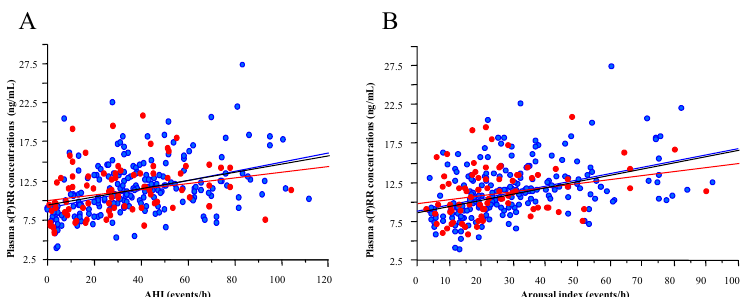
Int. J. Mol. Sci. 2017 , 18 , 1313 4 of 9 The presence of hypertension had no significant effects on plasma s(P)RR concentrations in both Figure 2. Significant correlations between plasma s(P)RR levels and apnea-hypopnea index (AHI) ( A ); male and female OSAS patients (Figure 3A,B). Moreover, the types of anti-hypertensive drugs had no significant effects on plasma s(P)RR concentrations in OSAS patients. On the other hand, the and between plasma s(P)RR levels and arousal index ( B ) in 289 subjects (206 men and 83 women). The presence of type 2 diabetes mellitus (T2DM) or chronic kidney disease (CKD) affected plasma s(P)RR subjects comprised of 259 patients with obstructive sleep apnea syndrome (OSAS) and 30 non-OSAS concentrations in OSAS patients in both sexes (Figure 3A,B). Female OSAS patients with both T2DM control subjects. The dark lines; trend for all subjects. The blue lines and blue circles; male subjects. The and CKD (diabetic kidney disease) showed higher levels of plasma s(P)RR than the other three groups (Figure 3D), whereas male OSAS patients with both T2DM and CKD did not (Figure 3C). red lines and red circles; female subjects. Reproduced from the Reference [23] with kind permission These findings suggested that the presence of diabetic kidney disease had a greater effect on plasma from the Tohoku University Medical Press, Sendai, Japan. s(P)RR concentrations in female OSAS patients.